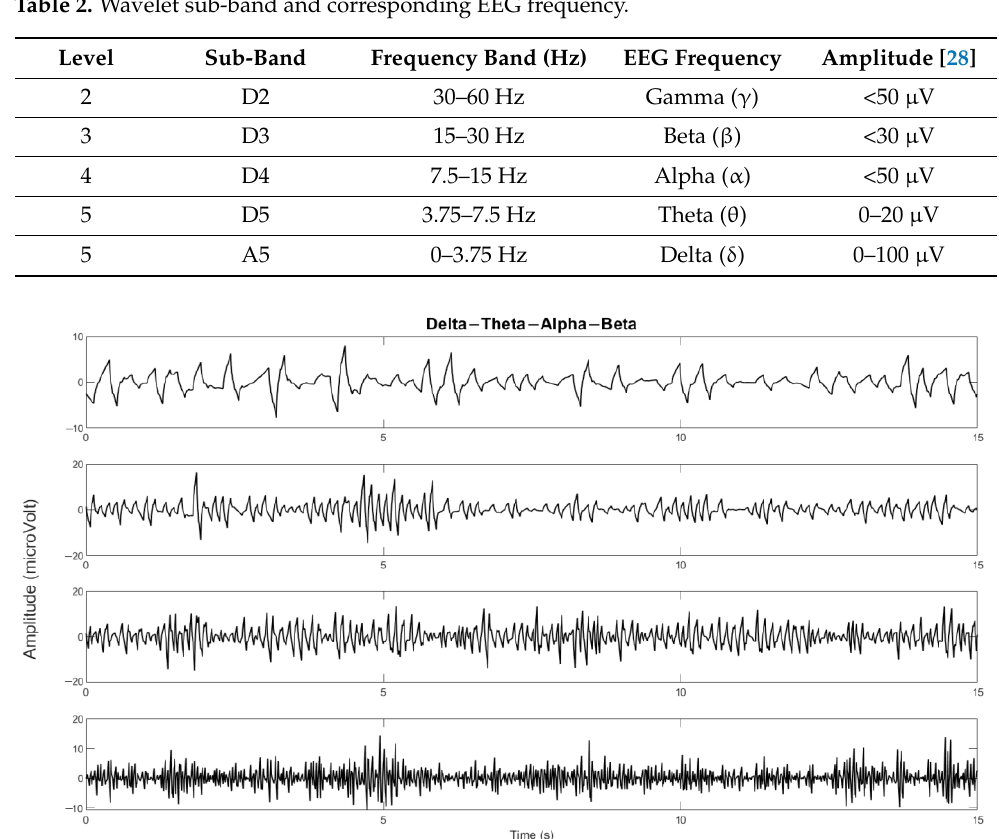
Figure 6. The delta, theta, alpha, and beta bands of one of the